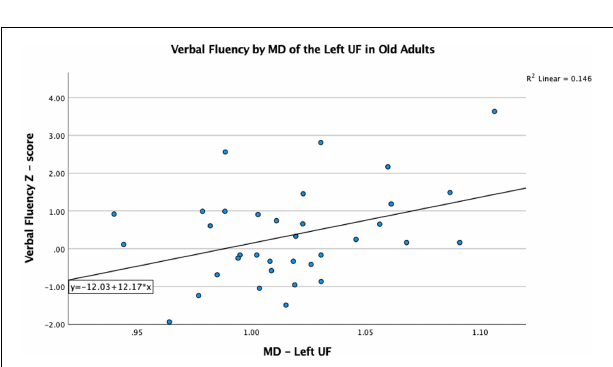
FIGURE 4 | Significant difference in UF by group comparison. Boxplot showing significant decrease in MD in old adults compared to young adults on the left UF. All relationships are considered at p < 0.00083 (Bonferroni multiple comparison 0.05/60 labels) after controlling for sex and education.